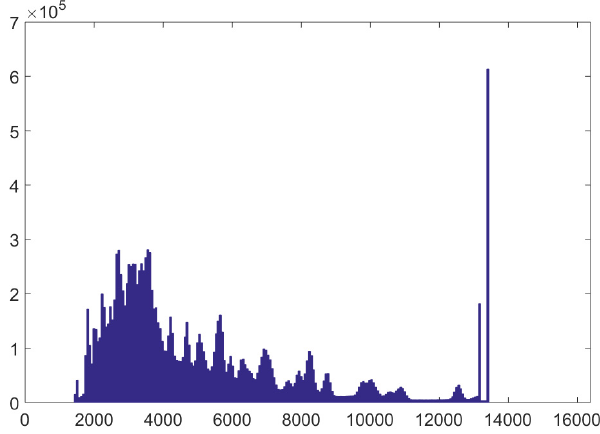
Figure 2. Histogram of an overexposed photo (white pixels). Maximum value 13,433